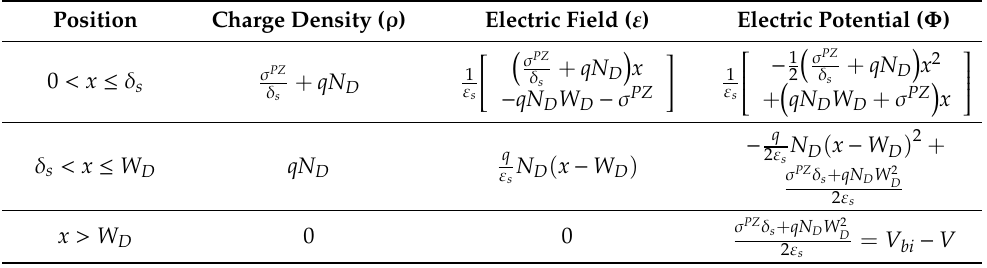
Figure 1. Mechanism of piezoelectric modulation in Schottky diodes. ( a ) Schematic illustration of the device with a Schottky contact and response under compressive ( σ PZ > 0) or tensile stress ( σ PZ < 0 ) . ( b – d ) Plots of ( b ) charge density, ( c ) electric field (inset: detailed plots of electric field near the end of depletion region) and ( d ) energy band edge diagram of the Schottky diode under compressive and tensile stress (inset: detailed plots at the peak of the band edge plots), respectively. ( e – g ) Current density vs. voltage characteristics with and without piezoelectric charges generated from the analytic solutions. ( e ) Semilog plot of current density vs. voltage curves. Linear plots of the curves with ( f ) forward bias and ( g ) reverse bias regimes. Black, red, and blue curves represent no stress, compressive stress, and tensile stress, respectively. Table 2. Charge density, electric field, and potential of the metal–semiconductor Schottky junction with piezoelectric